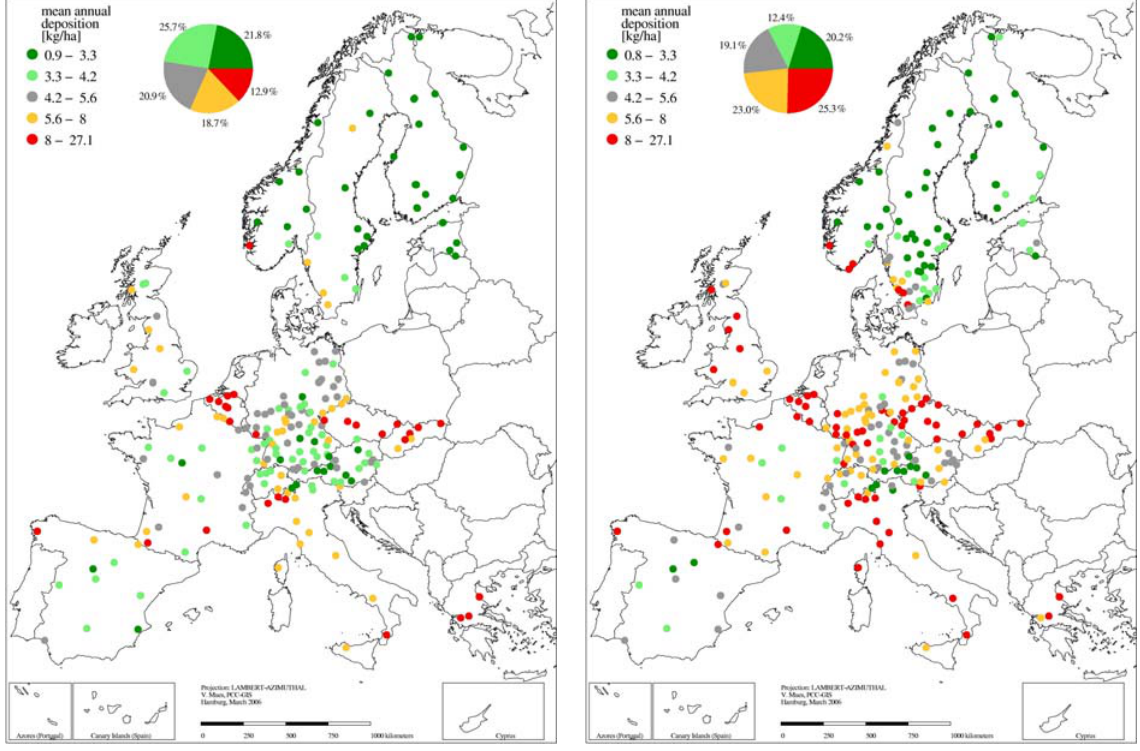
FIGURE 2. Mean annual bulk (left) and throughfall (right) deposition of S-SO 42– from